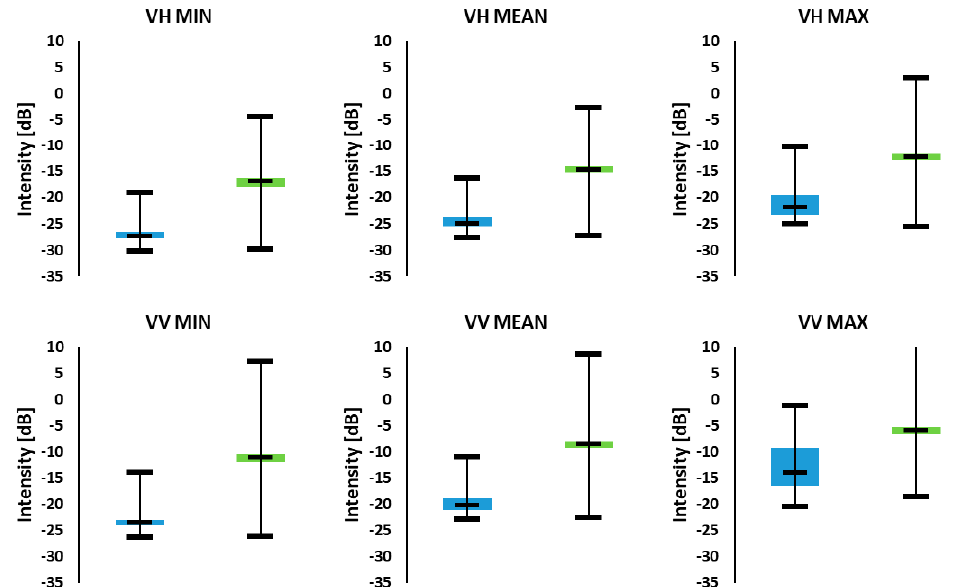
Figure 5. Boxplots on the land cover classes “water” (blue) and “agro-forest” (green) for Sentinel-1 time series features minimum (MIN), maximum (MAX), mean (MEAN) and for both polarization channels (VV / VH). Time series features were processed for the temporal subset “2016 / 2017”. The reference samples were taken from existing LULC classifications.